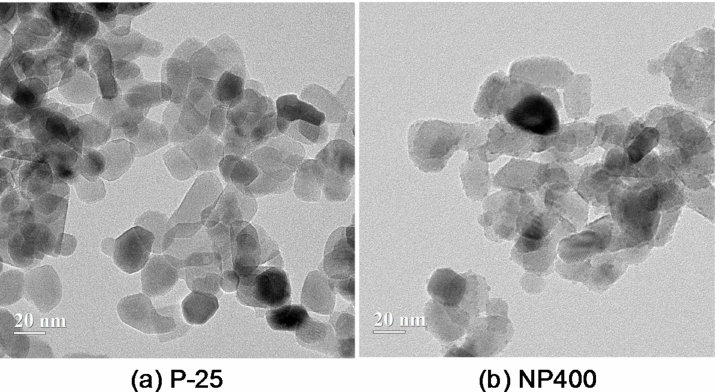
Figure 1. TEM images on the photocatalytic (titanium dioxide (TiO 2 )) materials: ( a ) the P-25 and ( b ) the